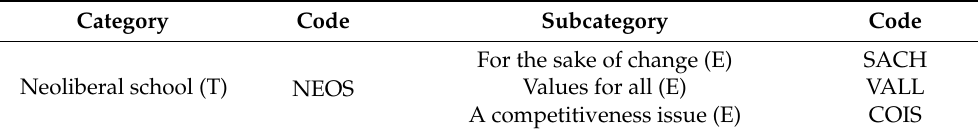
Table 3. Section of the general category system on which this work is focused.